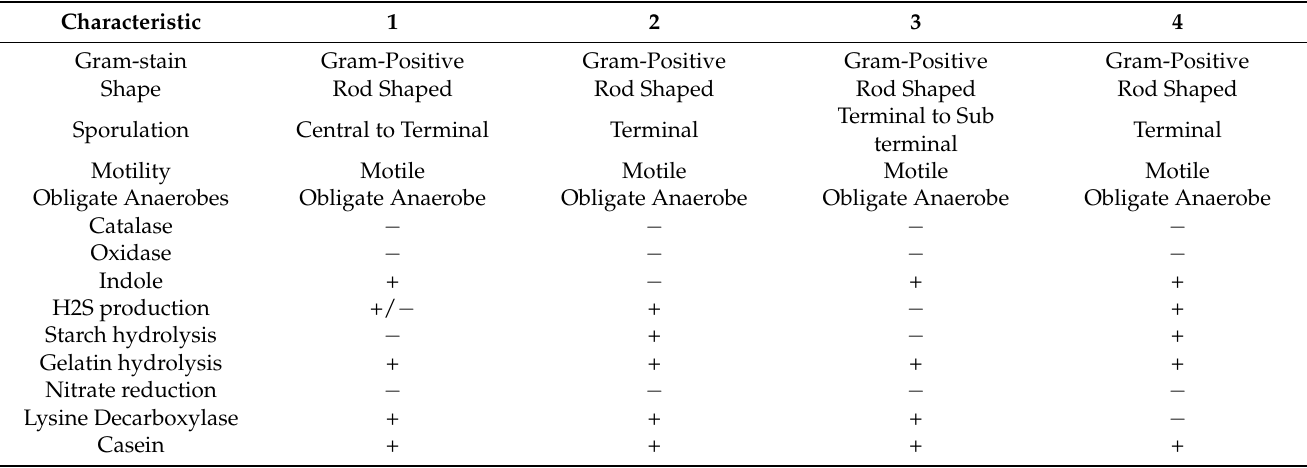
Table 4. General characteristics of Taxa: 1, P. bifermentans JCM 1386T [12]; 2, P. benzoelyticum JC272T [13]; 3, P. bifermentans subsp. Muricolitidis [12]; 4, P. bifermentans GBRC +, positive; − ,